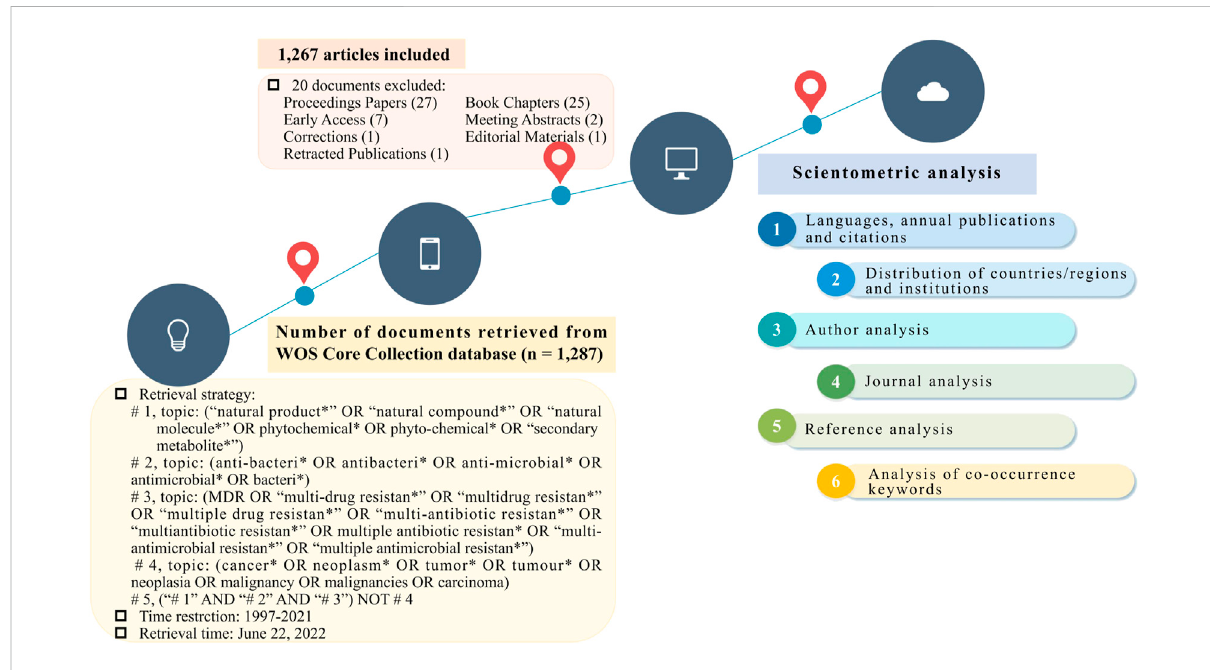
FIGURE 1 Process of literature identi fi cation, screening, and